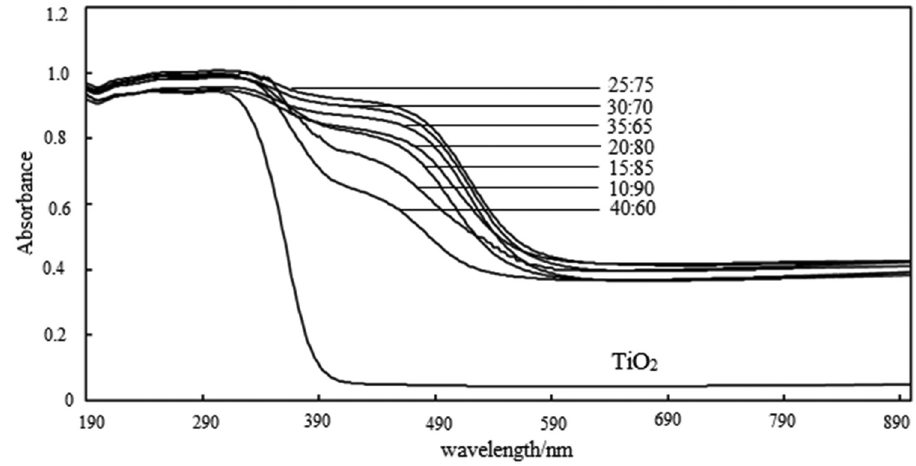
Figure 2: UV - Vis di ff use re fl ectance spectra of TiO 2 and CdS/TiO 2 composite